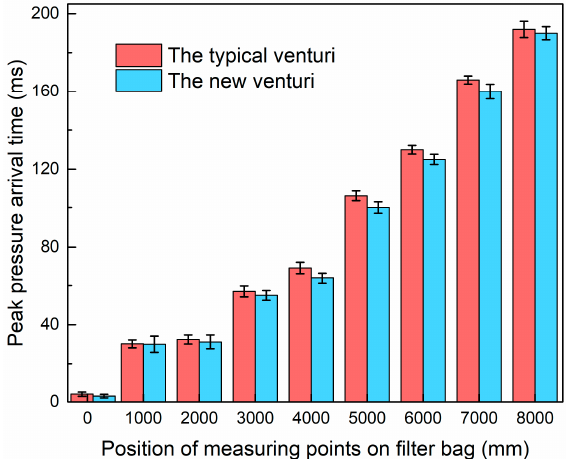
Figure 13. Effect of the new venturi-type on peak pressure. ( a ) Peak pressure at each measuring point. ( b ) Schematic diagram showing the cleaning pressure distribution on a filter bag with the new venturi tube.